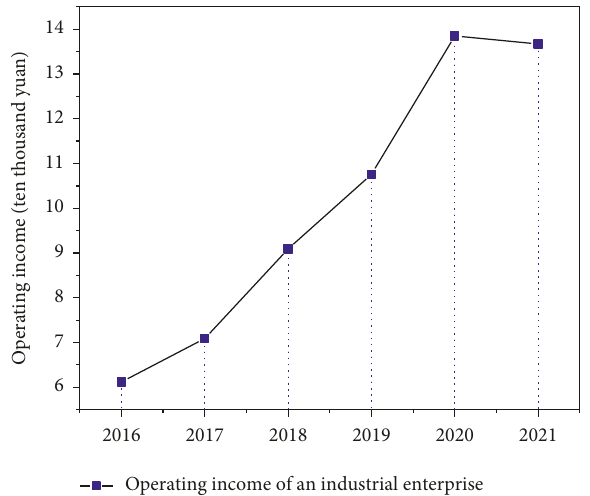
Figure 6: Operating income of an industrial enterprise (100 million yuan).